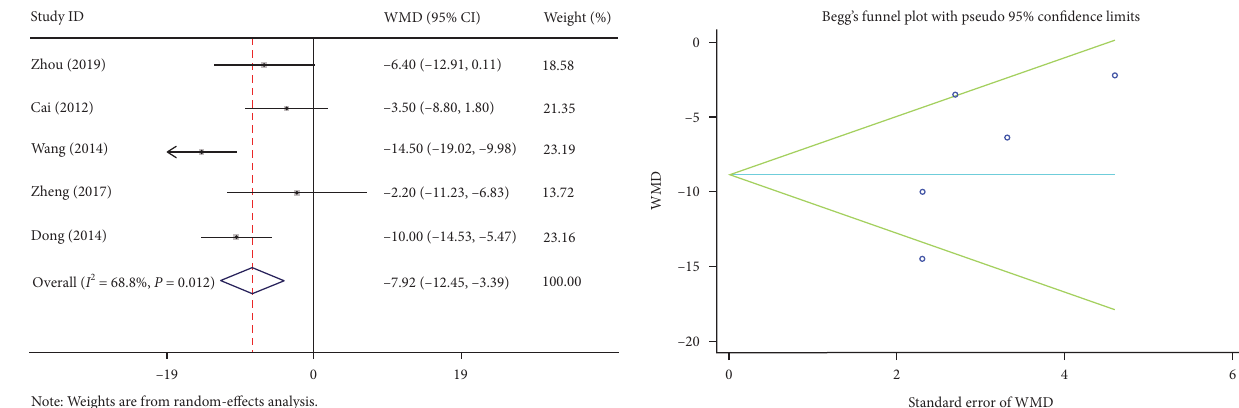
F IGURE 3: Forest plot and funnel plot of the intraoperative bleeding between the primary suture group and the T-tube drainage group.